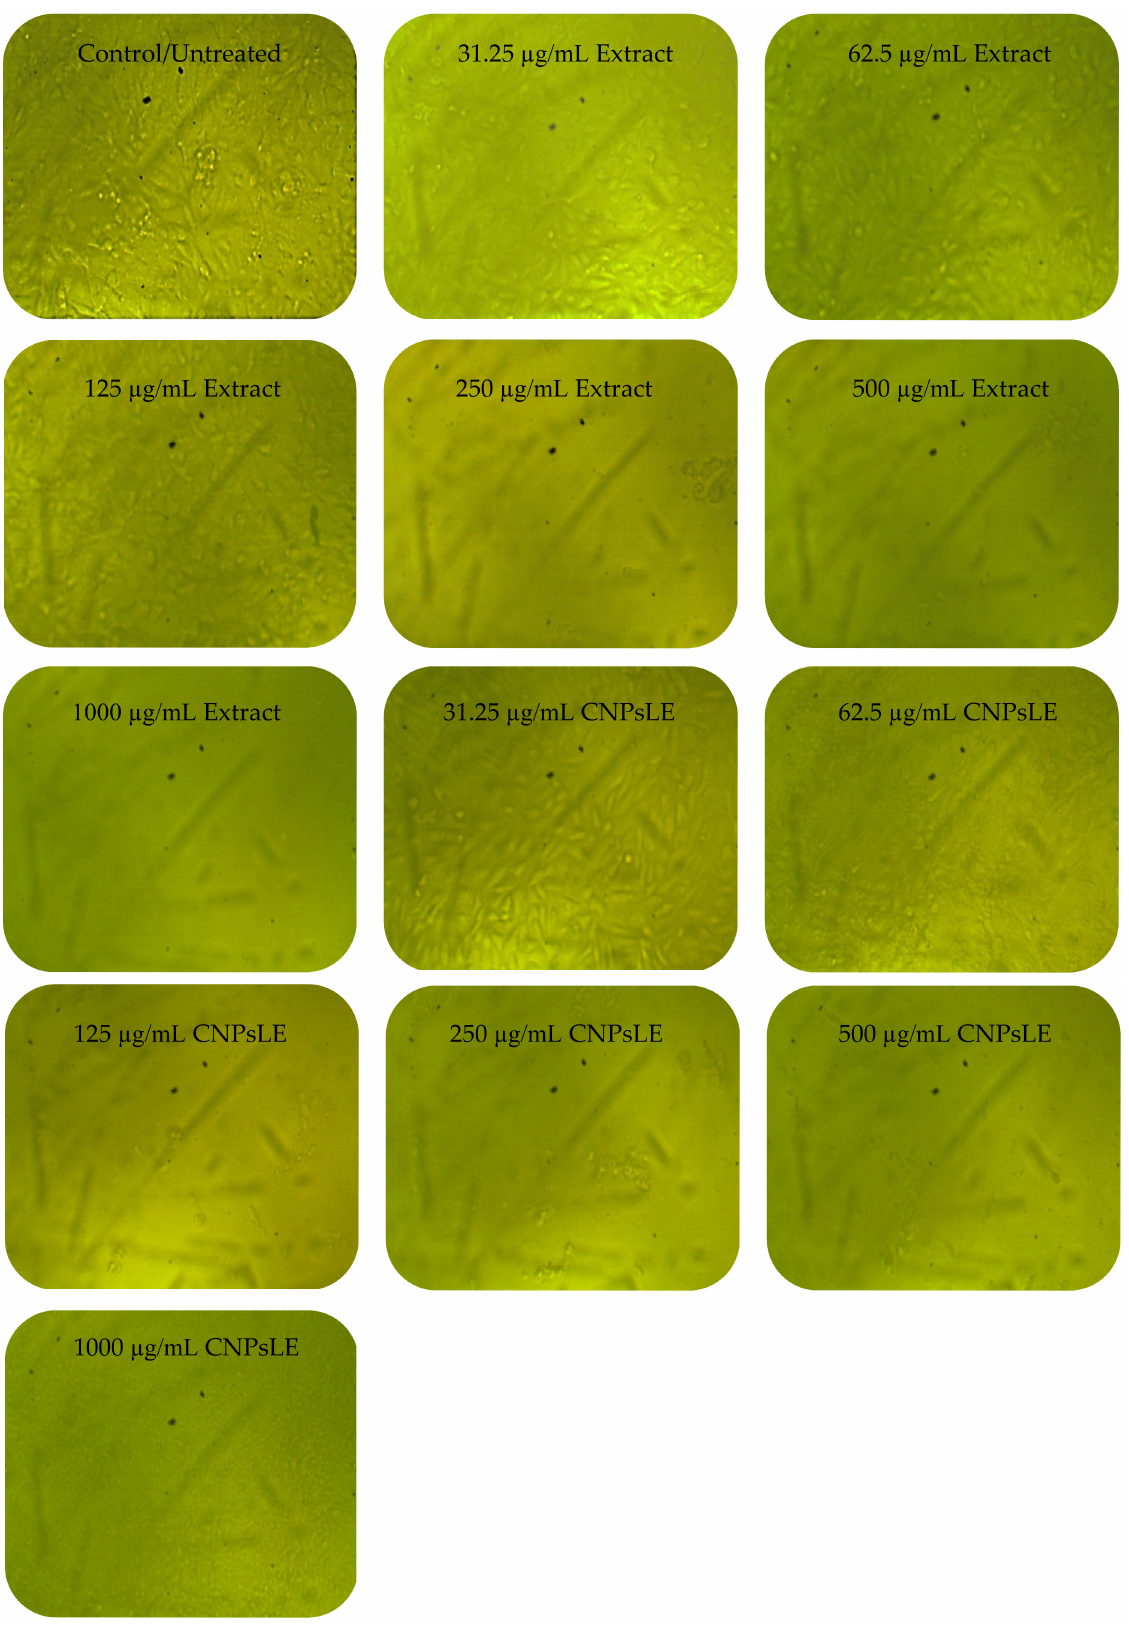
Figure 6. Images showing the cytopathic effect (CEP) of Vero cells treated with Artemisia judaica extract and Artemisia judaica extract loaded into chitosan nanoparticles (CNPsLE) at multiple